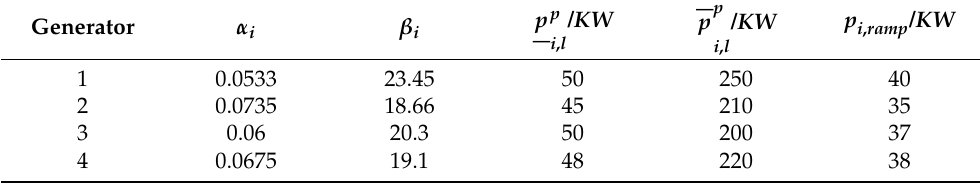
Table 1. Generator operating cost function parameters and output upper and lower